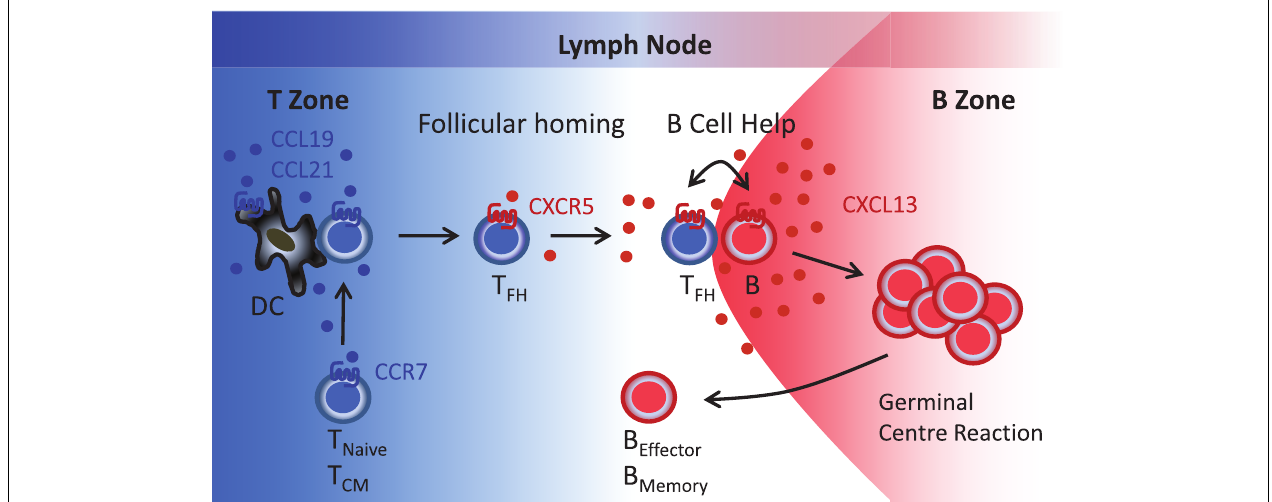
CXCL13 and to relocate to the B cell follicles where T FH -B cell interactions involving a series of co-stimulatory receptors (CD40, ICOS, etc.) and cytokines (IL-10, IL-21, etc.) initiate the germinal center reaction and the formation of antibody-secreting plasma cells and memory B cells. T Naive , naïve T cells; T CM , central memory T cells; T FH , follicular B helper T cells; B, B cells; B Effector , plasma cells; B Memory , memory B